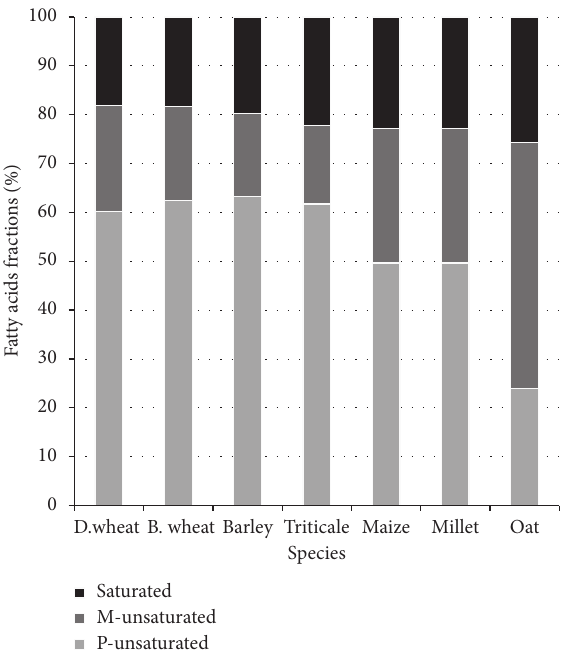
Figure 1: The saturated and unsaturated fatty acids fractions (%) of the studied cereal species; M: mono, P: